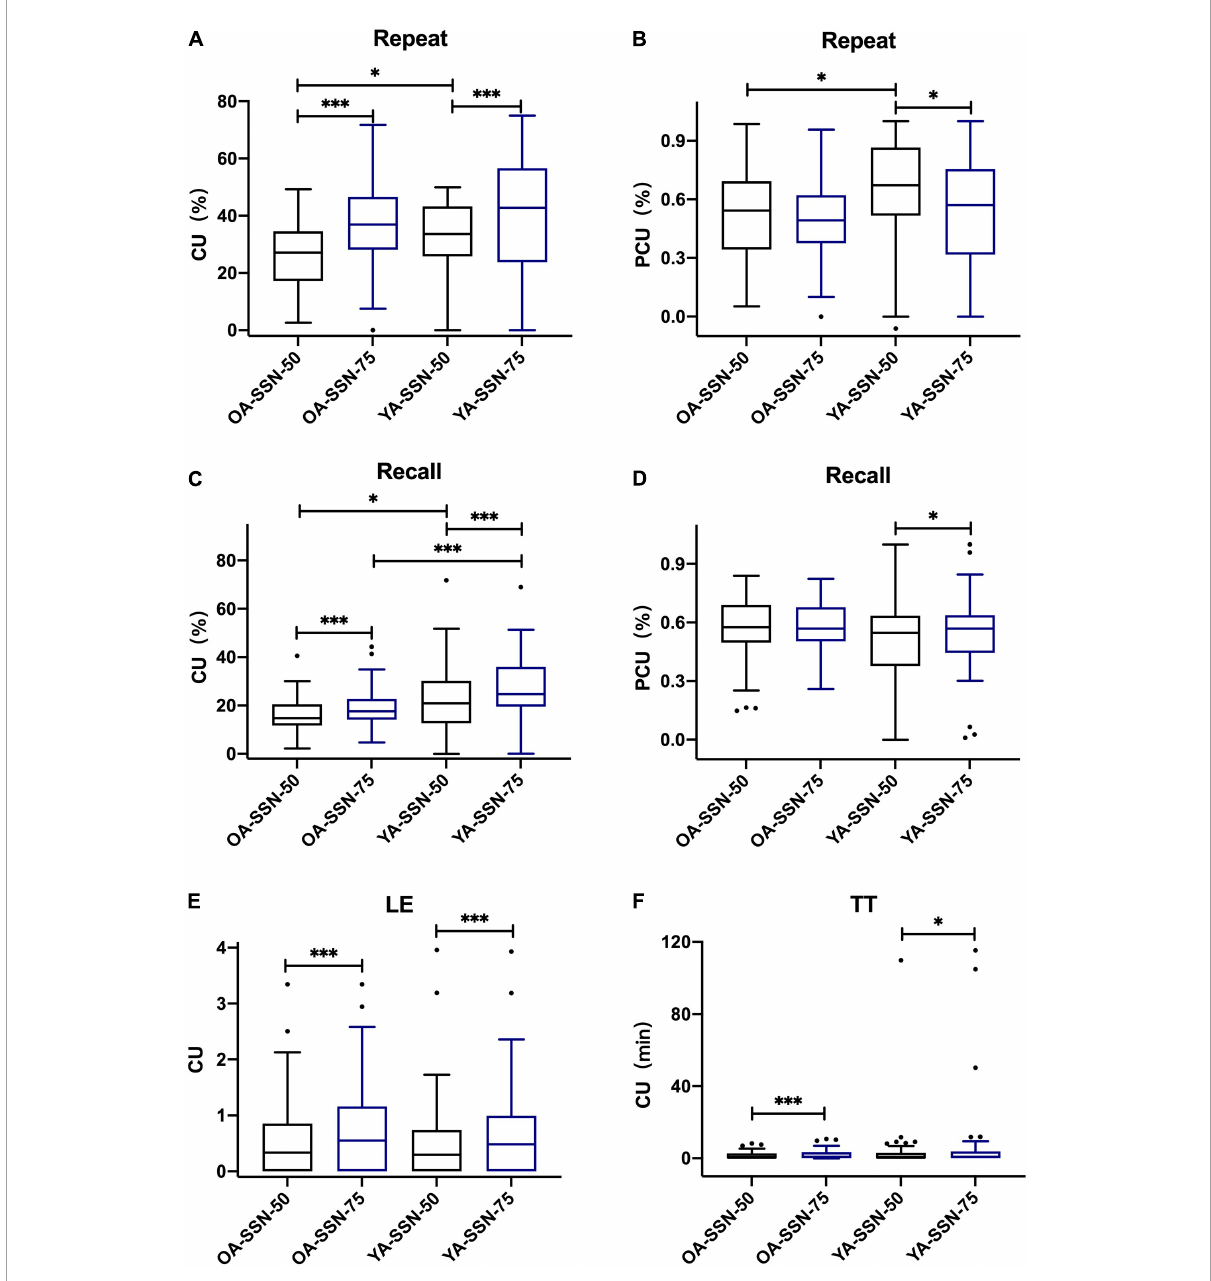
FIGURE5 P/CU performances under two SRTs in two age groups in SSN. (A) CU (Repeat 50% / 75% ), (B) PCU (Repeat 50% / 75% ), (C) CU (Recall 50% / 75% ), (D) PCU (Recall 50% / 75% ), (E) CU (LE 50% / 75% ), (F) CU (TT 50% / 75% ). All the figures were Boxplot. The top and bottom lines of a column represented the maximum and minimum values of the data, respectively. The top and bottom lines of the box represented the third quartile and the first quartile, respectively, and the line in the middle of the box represents the median of the data. Black circles represented outliers. ∗ P < 0.05, ∗∗∗ P <